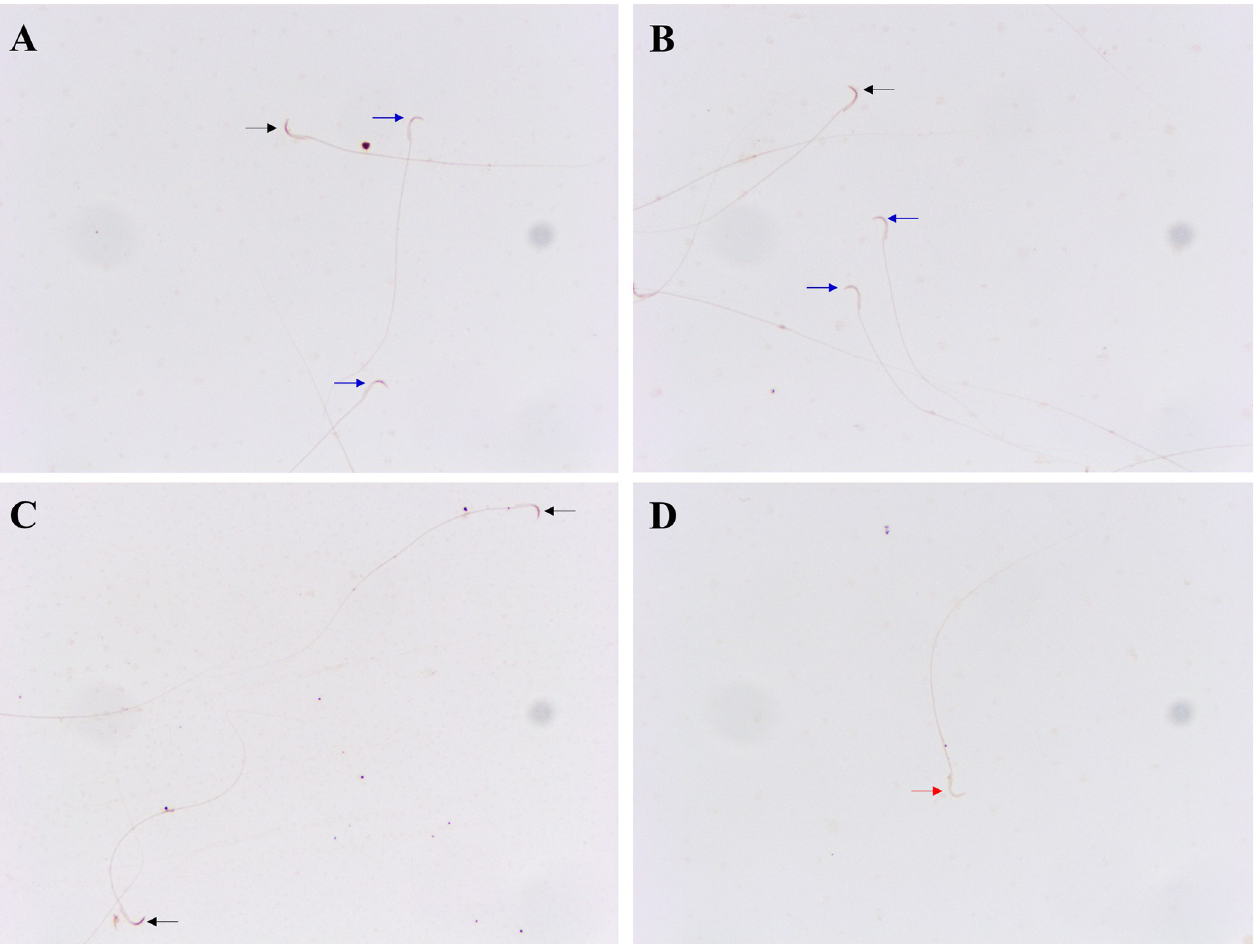
Fig 4. Negative-to-strongly-positive immunostaining for GABA A- α 1 receptor in rat epididymal spermatozoa at 200 × magnification. (A-C) Black arrows indicate the strong-positively stained sperm. (A, B) Blue arrows indicate the weak-positively stained sperm. (D) A red arrow indicates a negatively stained